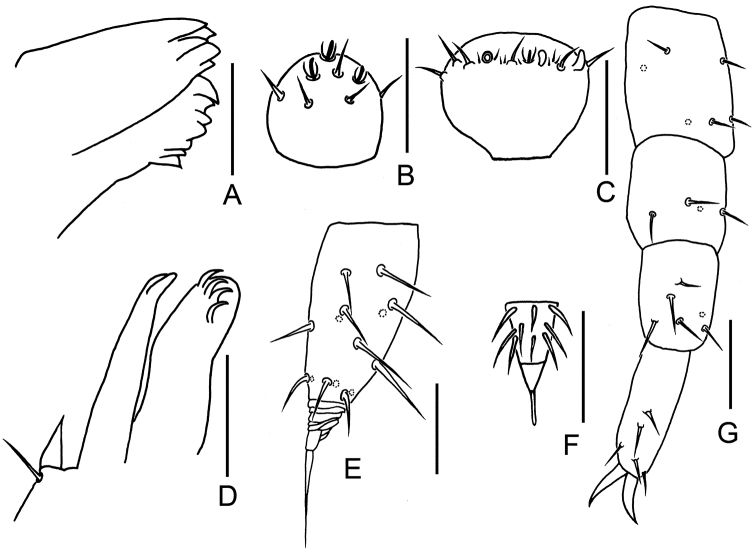
Symphylella
minuta sp. nov. A mandible B right apical antennomere, dorsal view C right 14th antennomere, dorsal view D first maxilla E right cercus, dorsal view F stylus on base of 4th leg, right side G 12th leg. Scale bars: 20 μm (A–E, G); 5 μm (F).